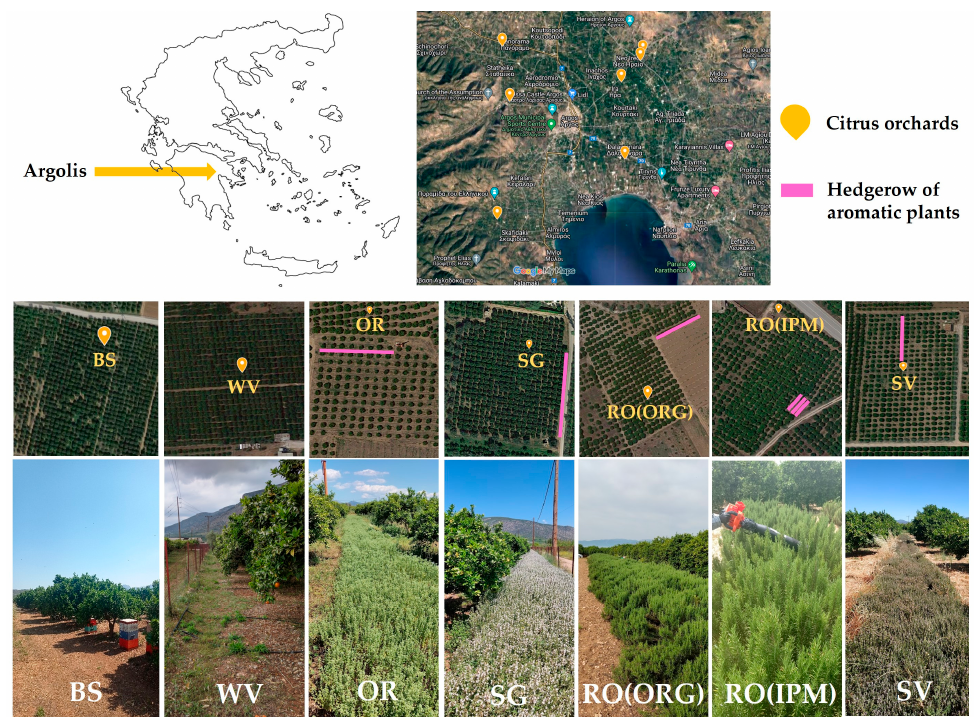
Figure 1. Experimentation sites of seven orange orchards in Argolis, Peloponnese, Greece, and layout of the aromatic plant hedgerows. [pink lines and photographs OR, SG, RO(ORG), RO(IPM), SV] and the control fields [weed vegetation (WV) and bare soil (BS)]. RO(ORG): rosemary hedgerow (organic orchard); RO(IPM): rosemary hedgerow (IPM orchard); OR: oregano hedgerow; SG: sage hedgerow; SV: savory hedgerow.